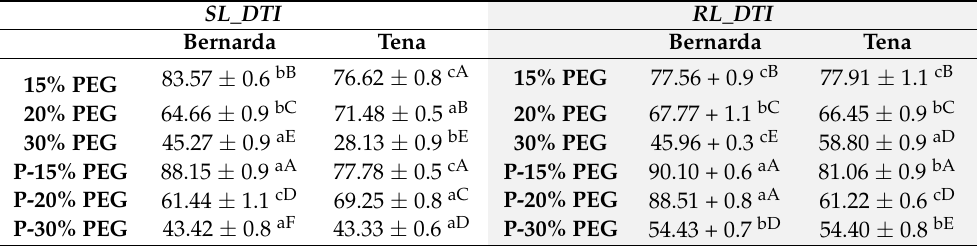
Table 7. Spearmanʾs correlation coefficients (r-values) among germination (G), shoot (S) and root (R) length, shoot length drought tolerance index (SL_DT), root length drought tolerance index (RL_DT) under drought treatments Table 6. Shoot (SL_DTI) and root (RL_DTI) length drought tolerance index of two wheat genotypes and high voltage electrical discharge (HVED) pretreatment (*, **, ***, significant at the 0.05, 0.01 and 0.001 after 5 days of growth under drought treatments (15%, 20% and 30% PEG), combined (P-15% PEG, levels). Numbers next to capital letters represent the treatment P-20% PEG and P-30% PEG) treatments, and high voltage electrical discharge (HVED) pre-treatment (P). Values are means of three repetitions (10 plants/repetition) ± S.D. The different capital letters indicate significances among means of different treatments within the same genotype, while lowercase letters indicate significances among means between genotypes under the same treatment at p < 0.05 using LSD post-hoc test. SL_DTI RL_DTI